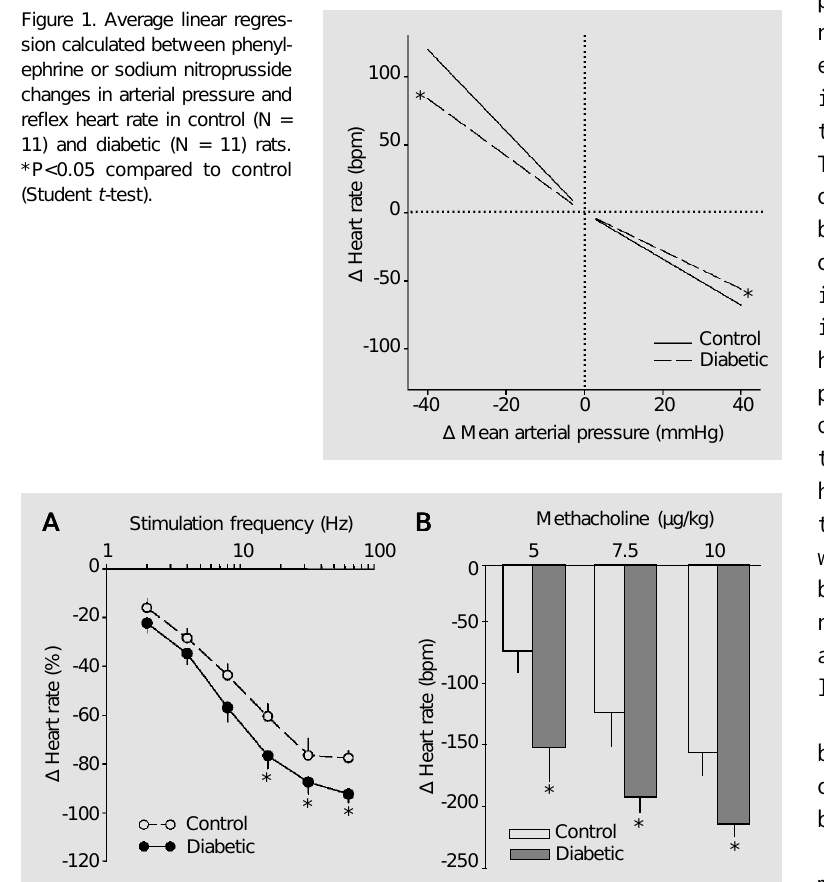
Figure 2. Effect of electrical stimulation of the right vagal nerve (A) on heart rate in control (N = 11) and diabetic rats (N = 11). B , Heart rate responses produced by increasing doses of methacholine (5, 7.5 and 10 µg/kg) in control and diabetic rats. Data are reported as means ± SEM. *P<0.05 compared to control (multivariate analysis of variance followed by Tukey